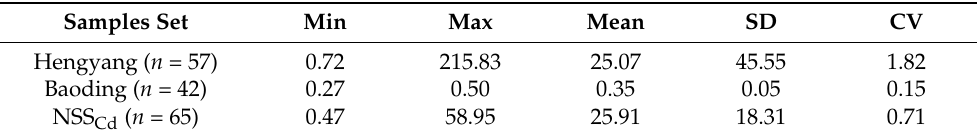
Table 2. Statistics of Cd concentrations (mg/kg) of different sample sets.